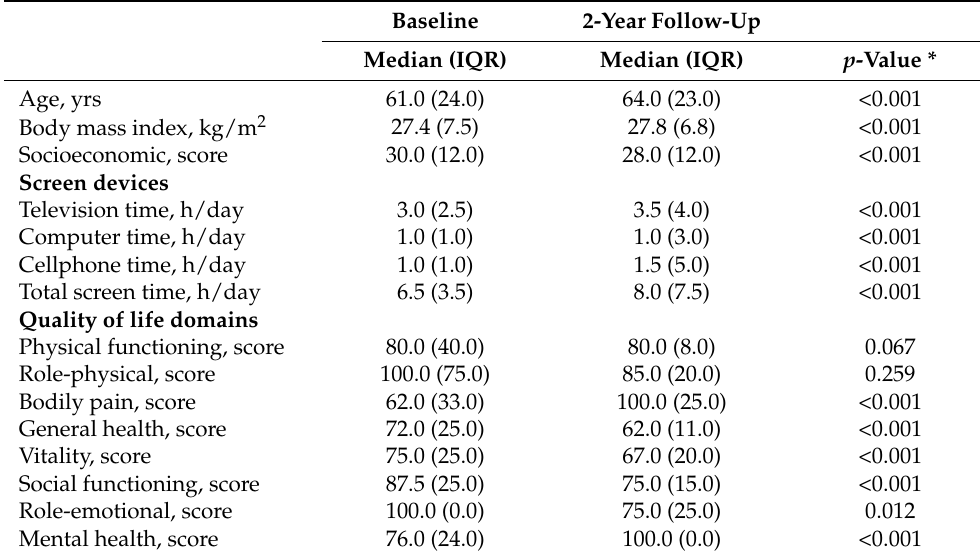
Table 1. Characteristics of the sample (n =